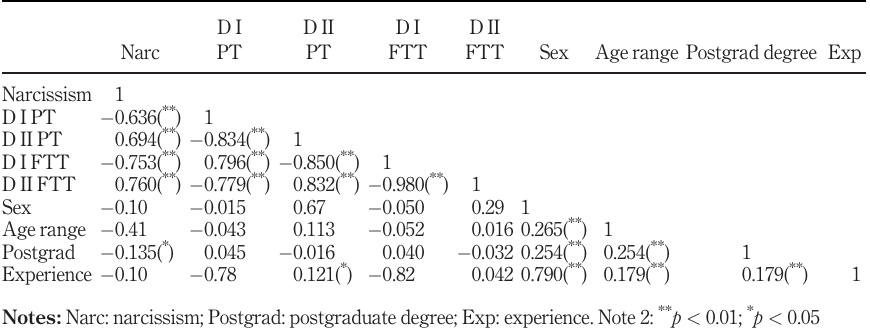
Table 4. Correlation